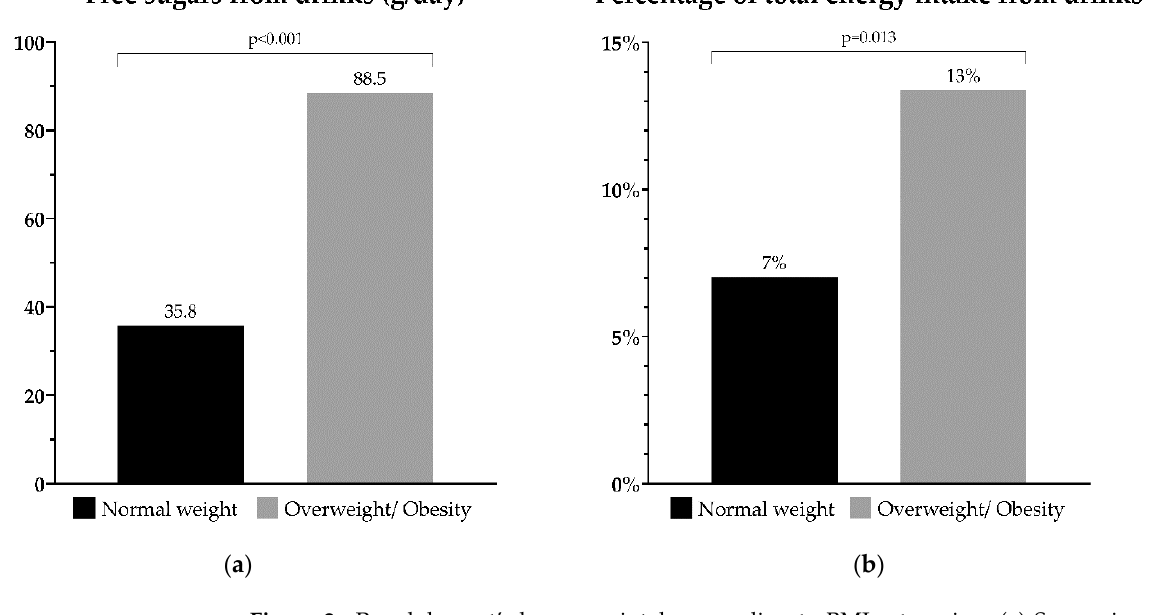
Figure 2. Preadolescent ’ s beverage intake according to BMI categories. ( a ) Sugars in g/day of beverage intake; ( b ) Percentage of daily energy intake from sugars of beverage intake.